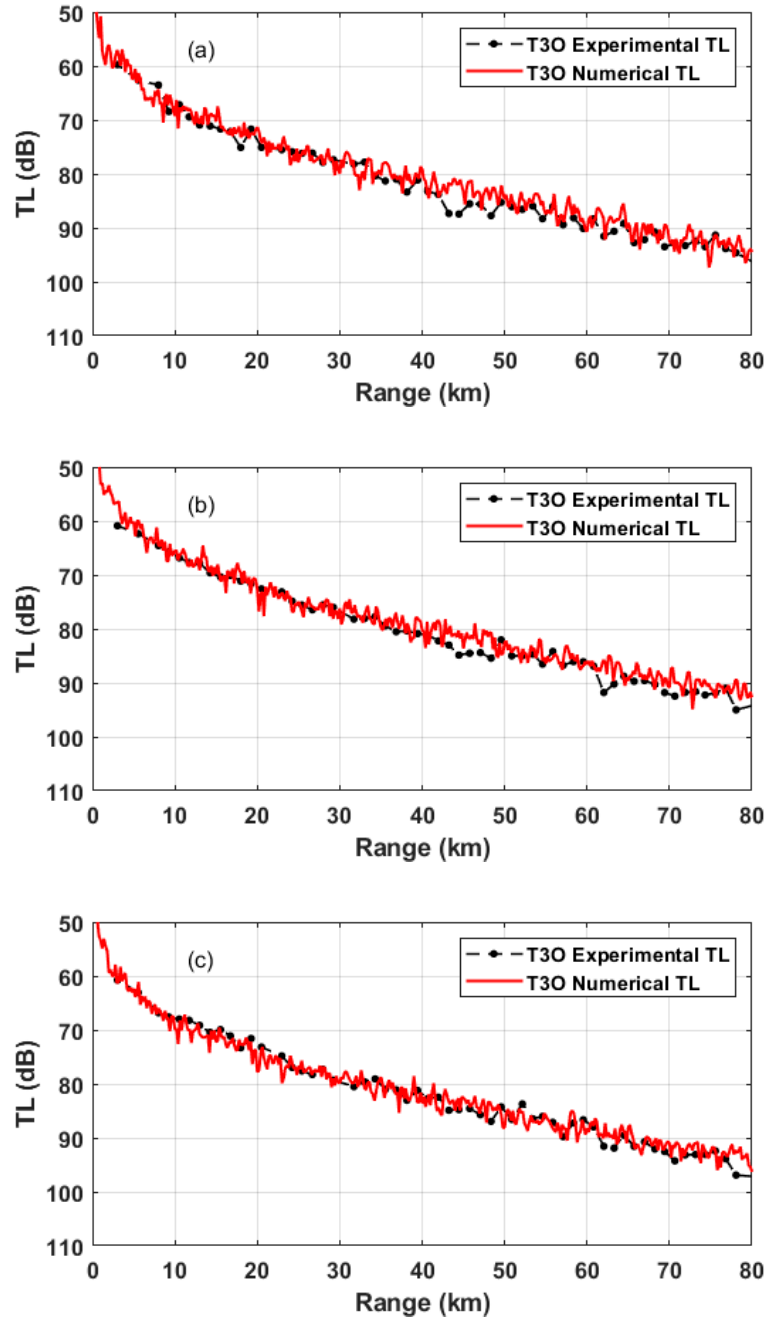
Figure 11. Comparison of numerical TLs result of T3O for central frequency 1000 Hz, source depth 7 m, and receiver depth 11 m ( a ), 37 m ( b ), and 71 m ( c